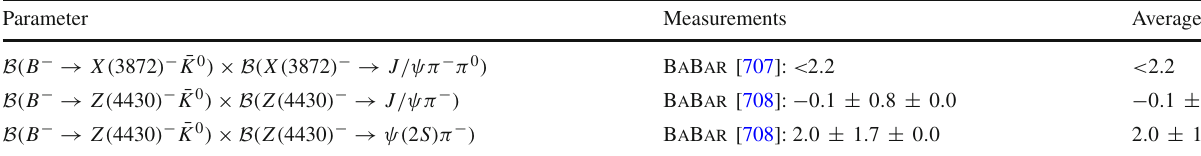
Table 178 Product decay rates to charged states [ 10 − 5 ]